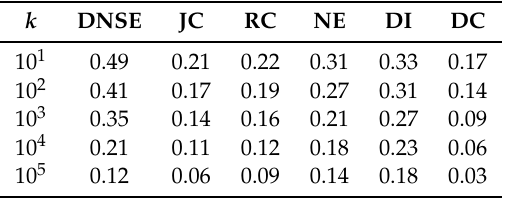
Figure 3. Detection rate and γ %-accuracy of DNSE( k ) for various dynamic parameter k . (we set the flipping parameter p = 0.3 and diffusion parameter q = 0.4, respectively.) ( a ) Detection rate vs. Budget B . ( b ) γ %-accuracy. Table 2. Detection probability of DNSE( k ) compared to other methods by varying k . We use the flipping parameter p = 0.3 and investigation budget B =